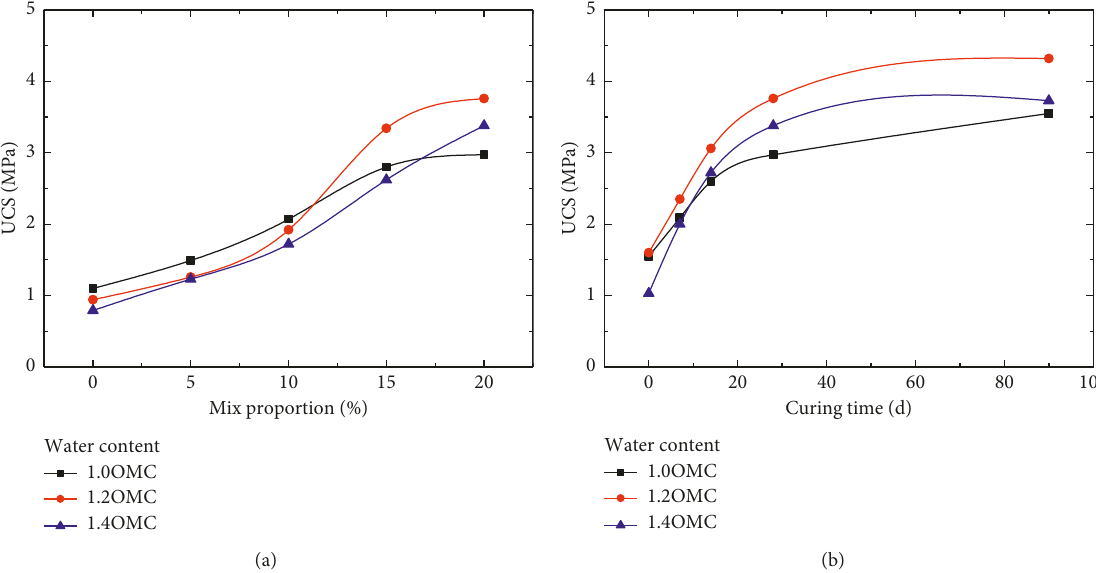
Figure 18: Unconfined compression strength of expansive soil stabilized by RHA-lime in different water content. (a) Effect of mix proportion; (b) effect of curing time.